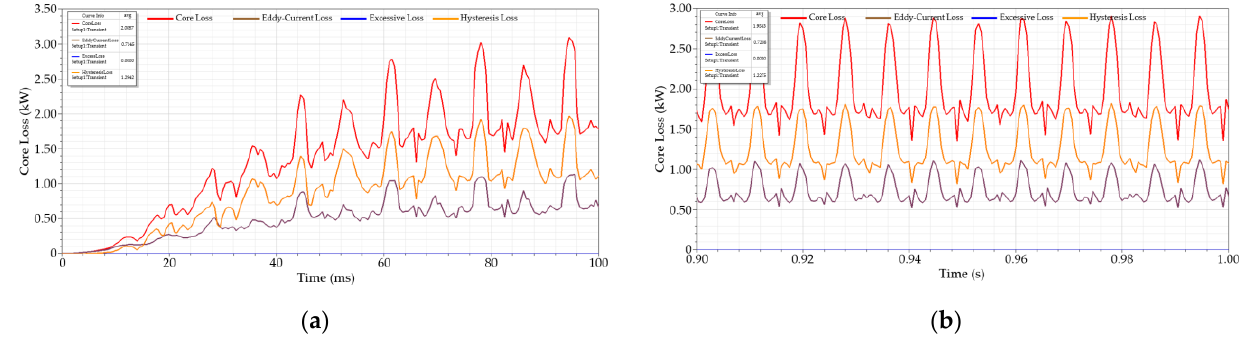
Figure 12. Simulation results of the core loss under the conventional equation. ( a ) 𝛽 = 50 ; ( b ) 𝛽 = 5.